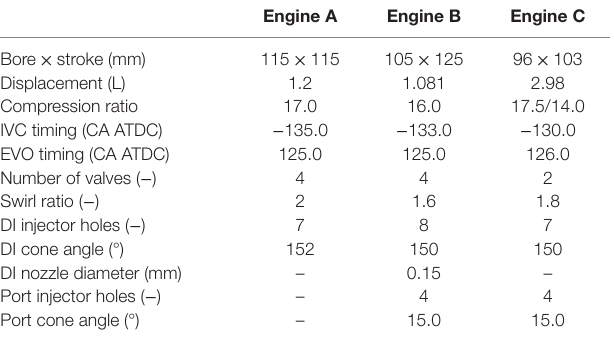
TABLe 1 | engine specifications (Yao et al., 2007c; Yang et al., 2012; Tong et al.,